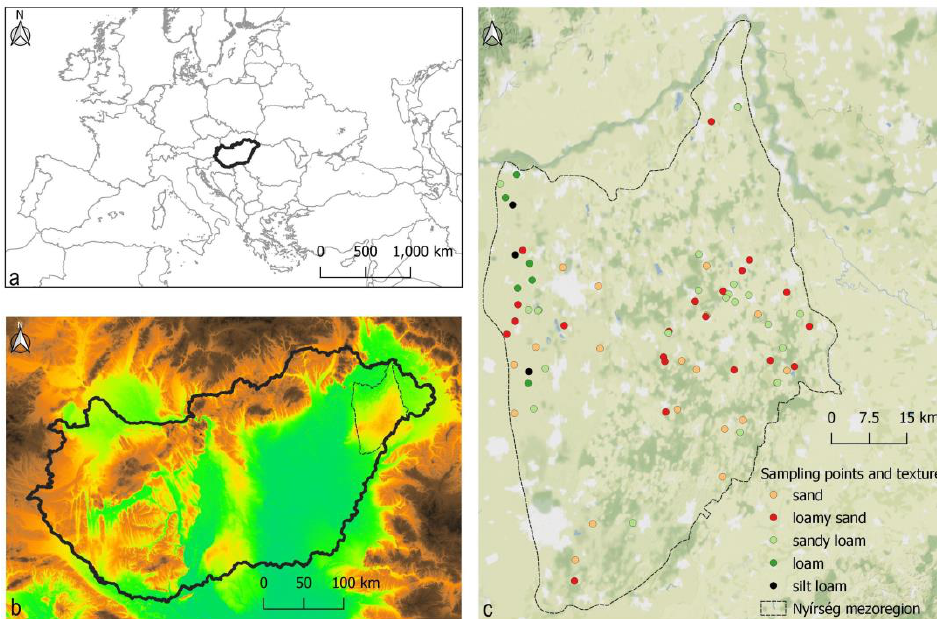
Figure 1. Location of the study area in Europe ( a ), in Hungary ( b ), and in the Nyírség mesoregion with sampling sites ( c ) (used background sources are: b: EU-DEM indicating the terrain heights, and c: Stamen Terrain – Open Street Map showing the settlements with white, arable lands with lighter green, and the forests with dark green).